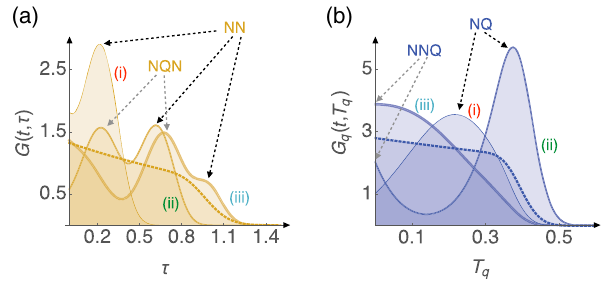
FIG. 5. Time evolution of age distributions of normal and quiescent cells. The solid curves in (a) and (b) show transient normal and quiescent cell-age distributions, respectively. We have plotted these distributions at t ¼ 1 . 2 , 1.6, and 2.05, corresponding to times labeled (i), (ii), and (iii), respectively, in Fig. 4(b). See the Fig. 6 legend for the parameter values used; for these parameter values, we find that μ τ ¼ 1 and μ The initial population consists of newborn normal cells. Each mode of a time-dependent age distribution corresponds to a specific lineage, as labeled above. The separations between different modes of multimodal time-dependent age distributions contain information about underlying timescales of division and differentiation. For instance, in (a), curve (ii) shows a bimodal normal cell-age distribution observed at t ¼ 1 . 6 . The separation between the two modes (corresponding to the lineages NN and NQN) is approximately equal to the differentiation timescale, μ ¼ 0 . 4 . The broadening of age distributions of each new T q lineage, because of fluctuations in division and differentiation times, results in steady-state age distributions (dashed curves) in which contributing lineages can no longer be distinguished. All curves were calculated from the exact analytical time-dependent solutions, which are presented in the Appendix. The δ -function corresponding to the initial age distribution has not been shown in (a). See Supplementary Videos 1 and 2 in [24] for the full time evolution of the age distributions corresponding to panels (a) and (b), respectively.